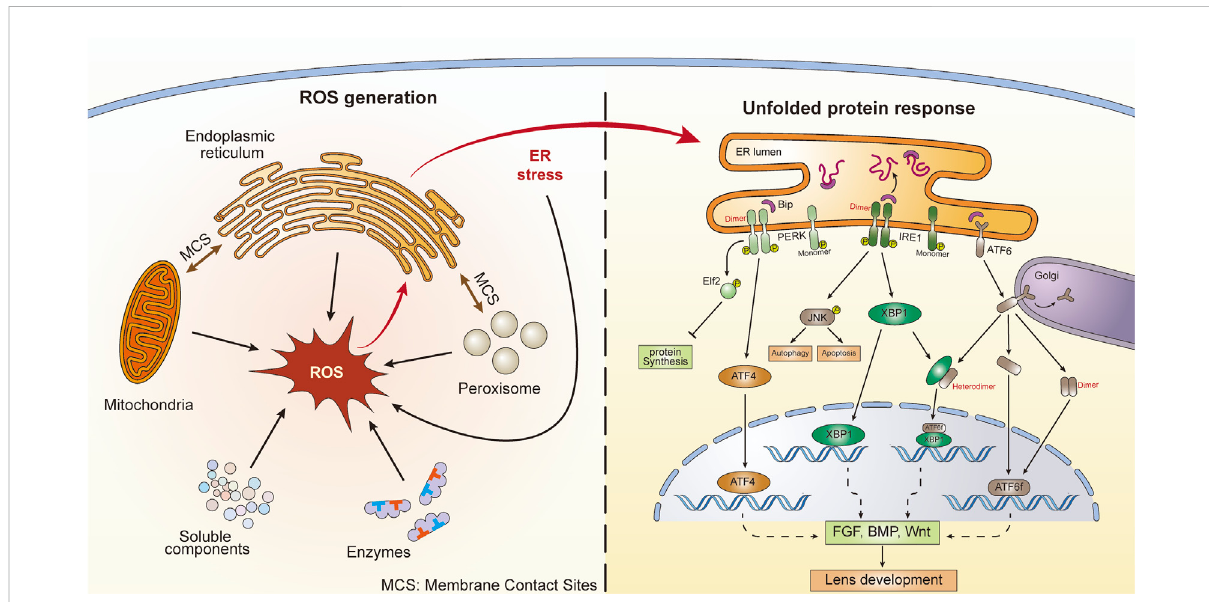
ROS generation and subsequent UPR activation in lens cells. There are fi ve main ROS sources, including enzymes, soluble components, mitochondria, peroxisomes, and the endoplasmic reticulum (ER). ER stress and UPR can also generate ROS. There are membrane contact sites between ERandmitochondria aswellas ERand peroxisomes. ThreeUPR signaling pathways areactivatedfollowingERstress,includingATF6, PERK, and IRE1. The dimerization and heterodimerization of key factors could lead to differential gene regulation. These UPR pathways might further in fl uence lens development through action on the FGF, BMP, and Wnt